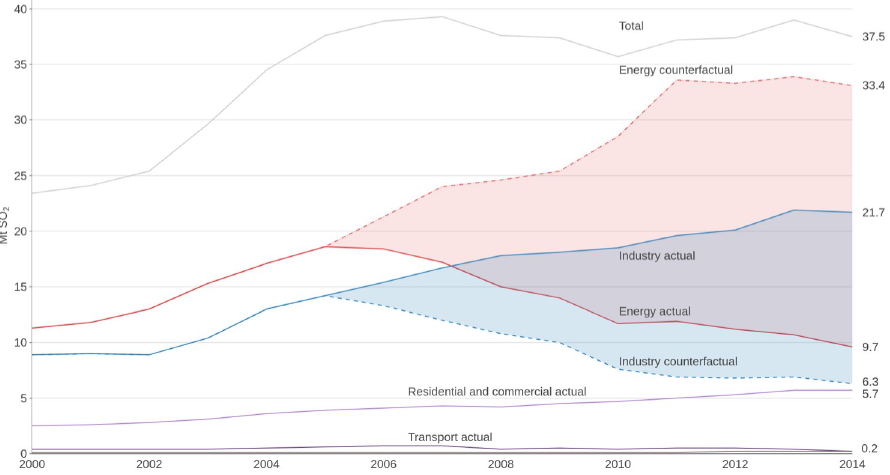
Fig 2. Yearly SO 2 emissions (Unit: Megatonnes, Mt) in China. Emissions from energy generation, industry, residential and commercial, and transport sectors based on the bottom-up inventory of anthropogenic emissions Community Emission Data System [19]. Solid lines are actual emissions; the dashed ones are the counterfactual scenarios. The four sectors account for 99% of SO 2 emissions; the remainder comes mainly from waste